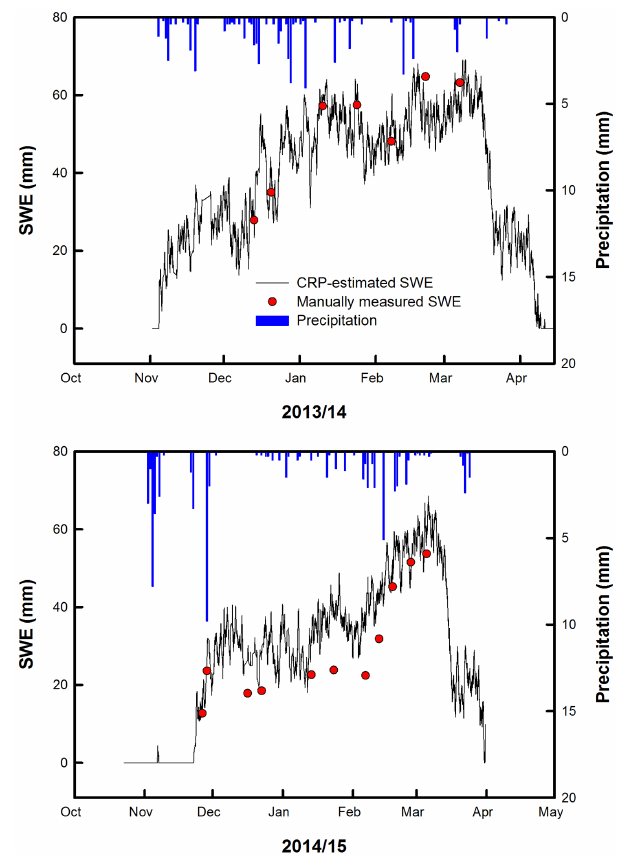
Figure 5. CRP-estimated SWE and manually measured SWE for 2013/2014 (top) and 2014/2015